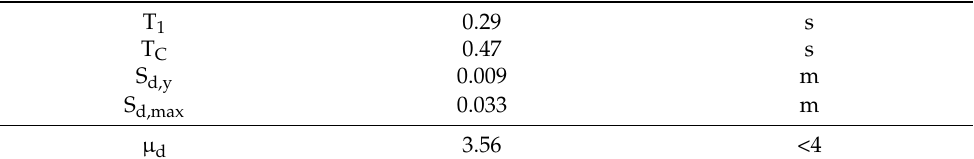
Table 8. Ductility request for case study